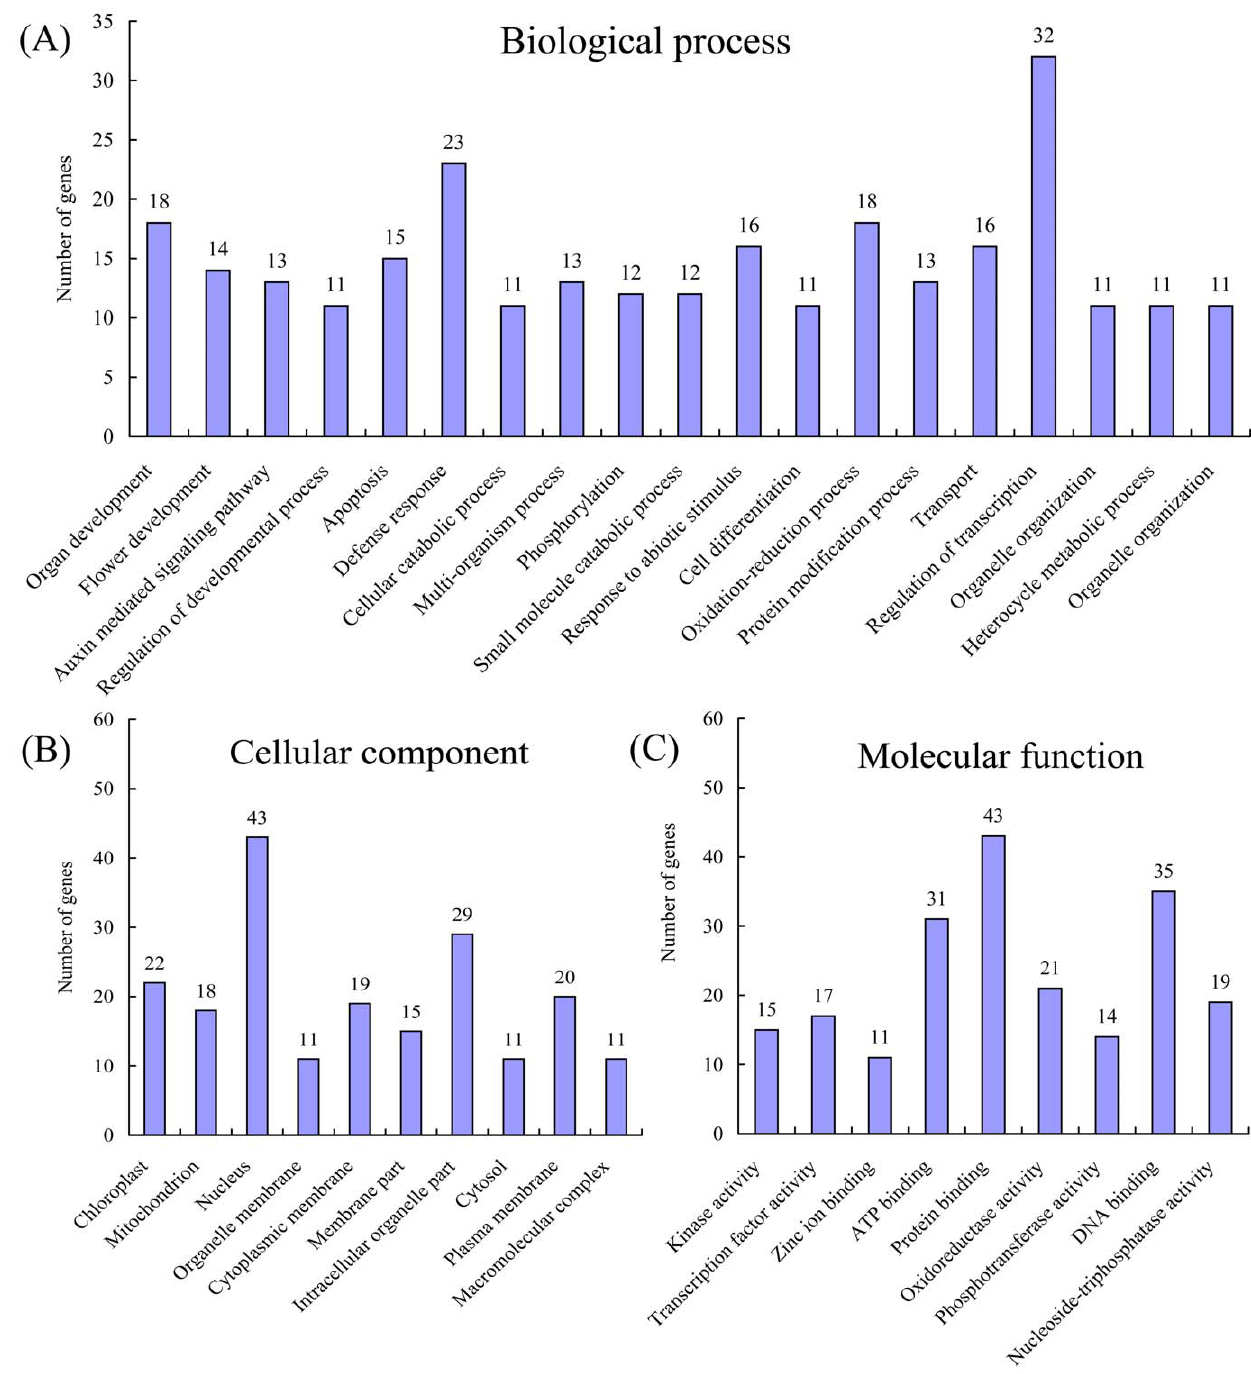
Figure 6. Gene ontology categories of target genes of the 51 novel miRNA families. Categorization of miRNA-target genes was performed according to the biological process (a), cellular component (b), and molecular function (c).